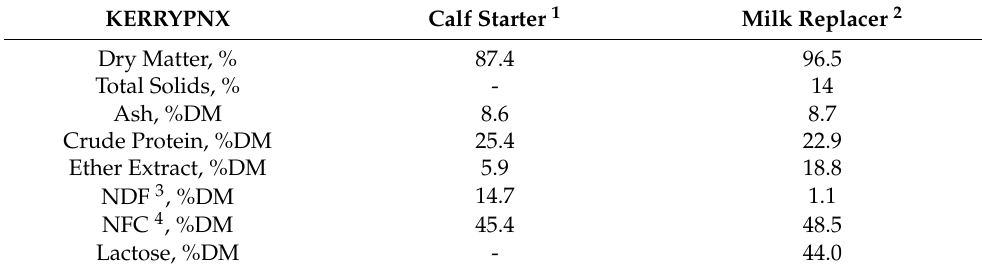
Table 1. Chemical composition of calf starter and milk